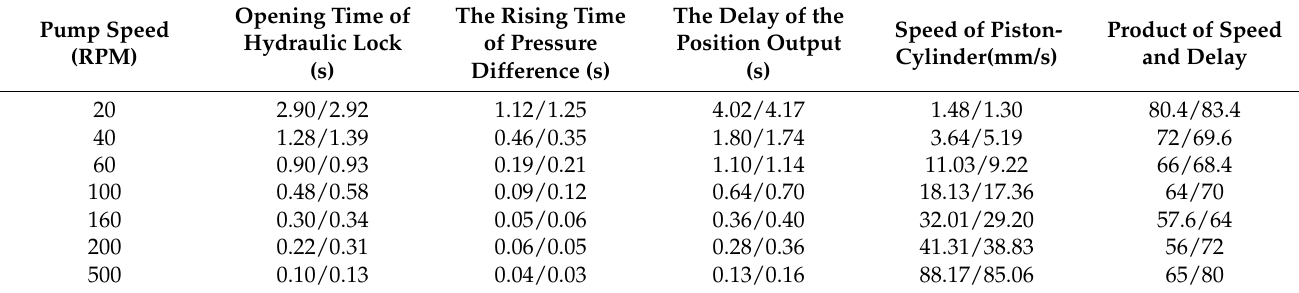
Table 4. The opening time of the hydraulic lock, the rising time of the pressure difference of the piston-cylinder, and the position delay (experiment/simulation).